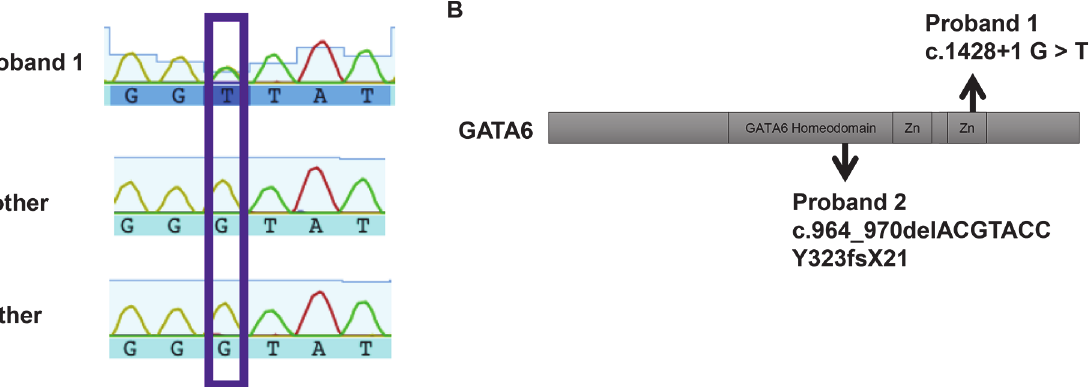
Fig 1. GATA6 variant proband 1. A) DNA sequence of proband and parents showing a single base pair change from G in the parents to a T in the proband at nucleotide position c.1428+1 G > T. B) Diagram of the GATA6 protein containing a GATA family homeodomain and two DNA binding zinc fingers. Arrows indicate locations of GATA6 variants discovered in proband 1 and